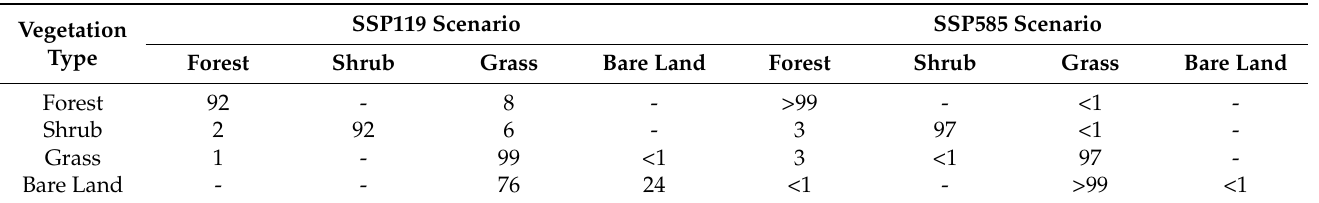
Table 2. Proportion (%) of vegetation type conversion area in the total area of the Loess Plateau